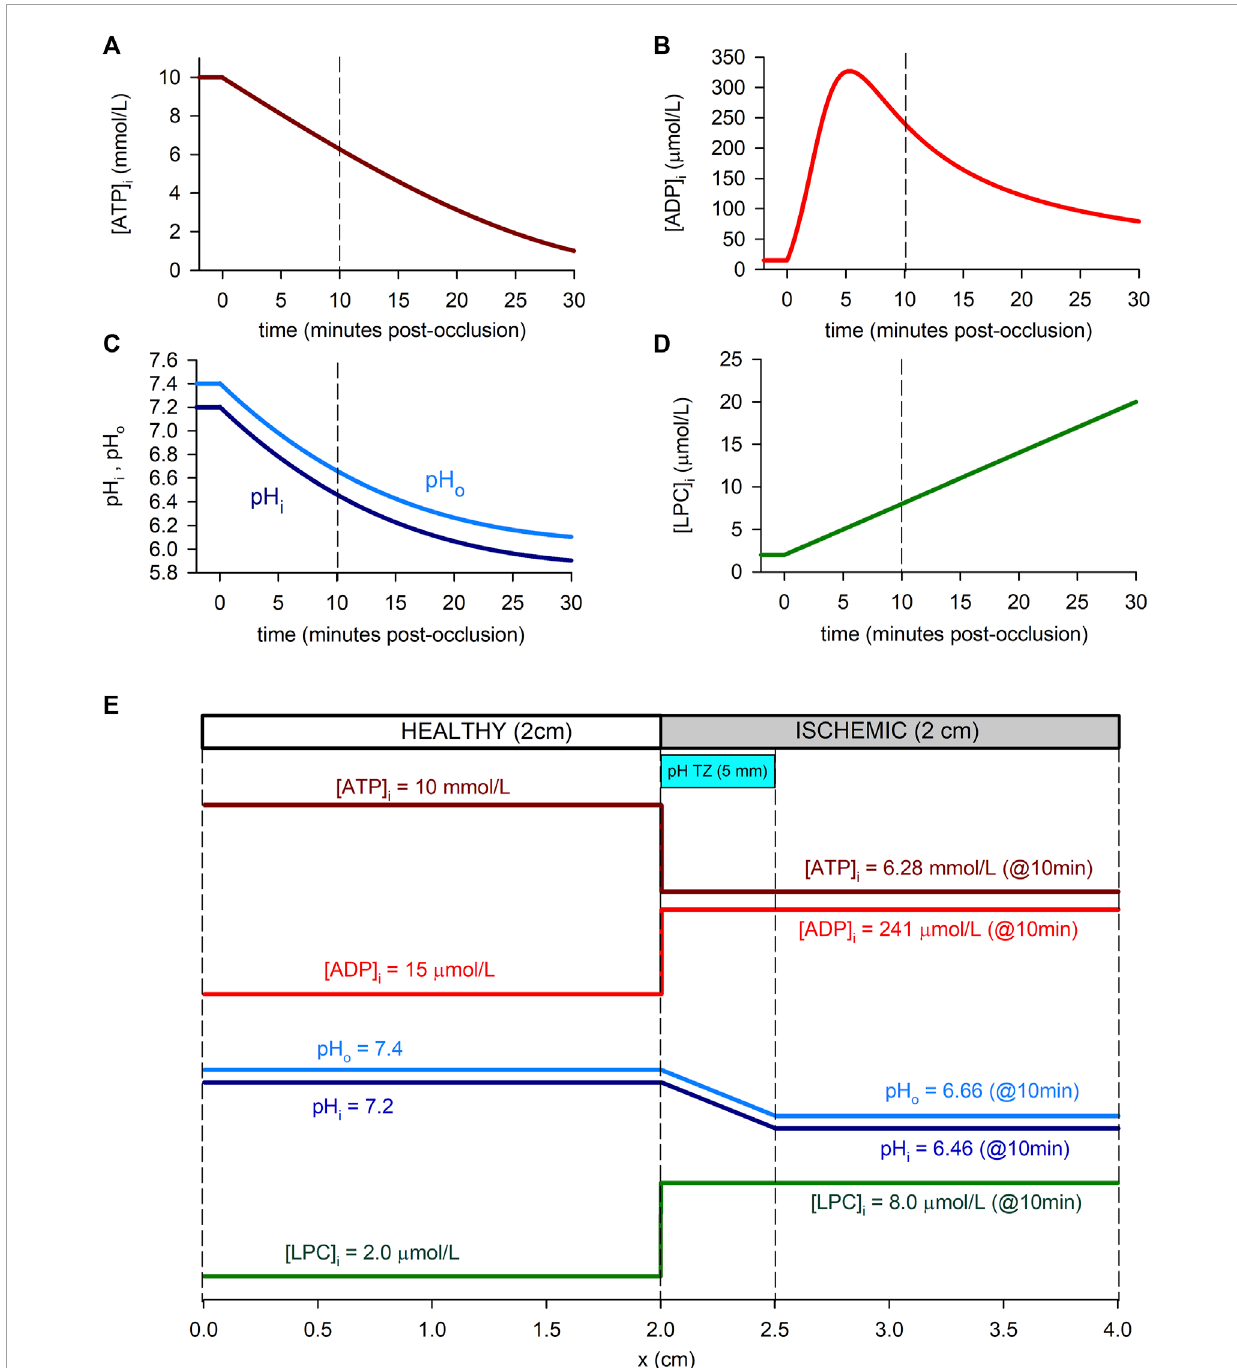
FIGURE 1 Time course of ischemia-related parameters in the simulated cell (“0D simulations”, panels (A–D) and spatial profiles in the simulated tissue (“1D simulations”, panel (E) . (A) : Intracellular ATP concentration. We adopted the time course reported by Sakamoto et al. (2000) for guinea-pig (at 37°C) with the normoxic value of O’Hara et al. (2011) and Cao et al. (2018). (B) : Intracellular ADP concentration, assuming a time course as reported by Terkildsen et al. (2007), based on Befroy et al. (1999) for guinea-pig at 37°C. (C) : Intracellular and extracellular pH, adopting the time course for guinea-pig reported by Sakamoto et al. (2000) (at 37°C) and a normoxic value for pH o by Vaughan-Jones et al. (2009). (D) : Intracellular LPC concentration, assumed linear and estimated using data from Gautier et al. (2008) in rat at 22°C and Daleau (1999) for guinea-pig at 30°C. (E) : Spatial profiles of the ischemic parameters in relation to the simulated 1D tissue. As an example, values within the ischemic part of the strand correspond to 10 min post-occlusion [dashed lines in panels (A–D) ]. A pH transition zone (pH TZ) was assumed to be 0.5 cm wide Coronel et al. (1988). pH was assumed to vary linearly within that